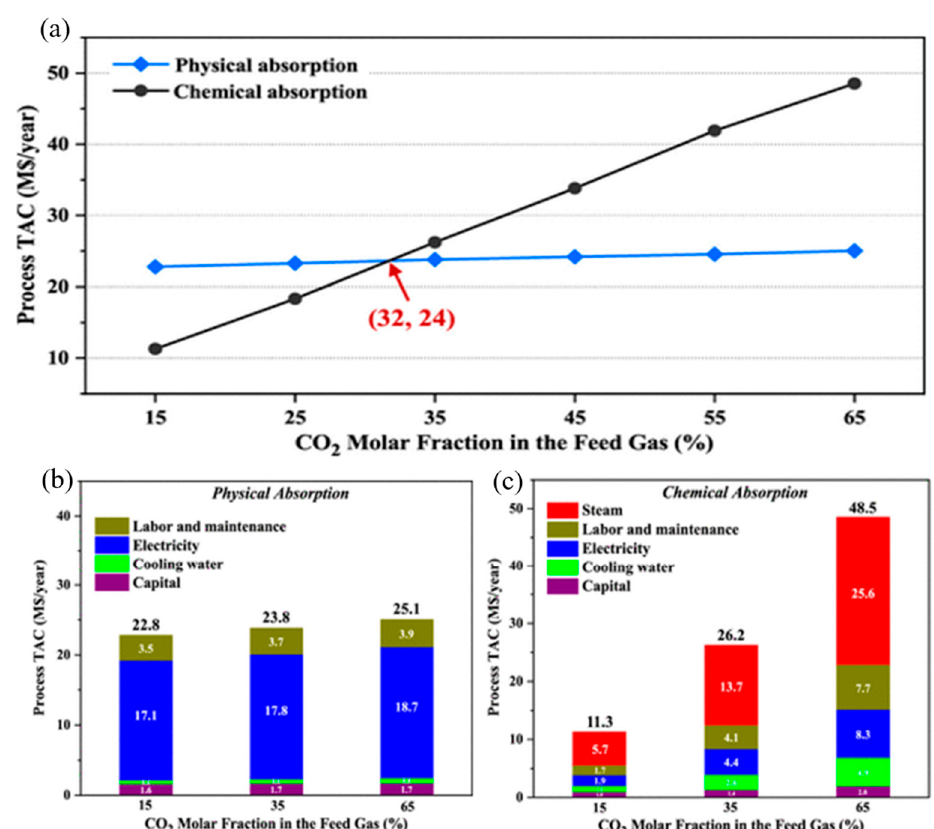
Figure 9. ( a ) Total annualized cost and ( b ) cost breakdown analysis at atmospheric pressure for feed gases with 15, 35, and 65% CO 2 for physical and ( c ) chemical absorption processes. Reprinted (adapted) with permission from [213]. Copyright 2020 American Chemical